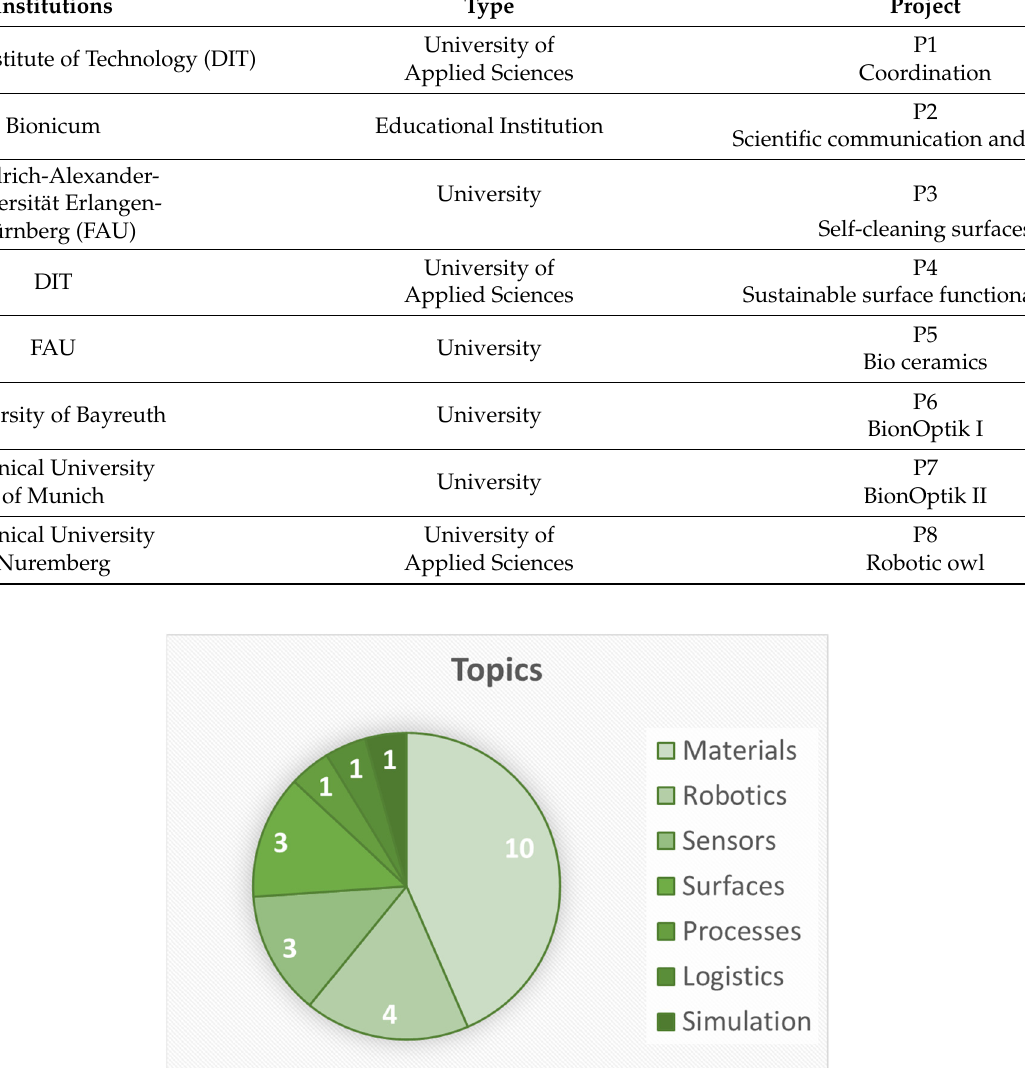
Figure 1. Topics of research proposals in the context of biomimetics addressing sustainability.